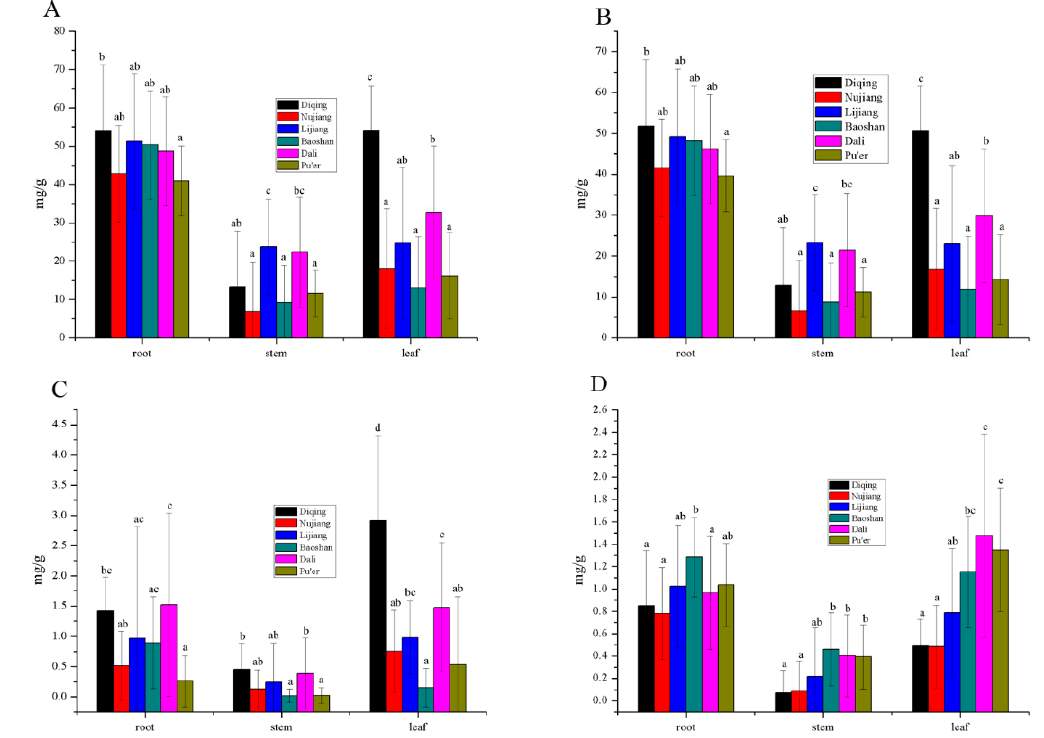
Figure 6. Different parts (root, stem, and leaf) in the content of total secoiridoids ( A ), gentiopicroside ( B ), sweroside ( C ), and swertiamarin ( D ) of G. rigescens in the western Yunnan Province ( P < 0.05).